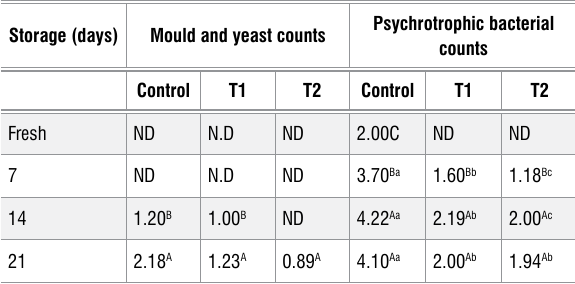
Data are expressed as a mean of three replicates. Means with the same uppercase letter superscripts indicate insignificant difference between columns ( p ˃ 0.05), and means with the same lowercase letter superscripts indicate insignificant difference between rows ( p ˃ 0.05).